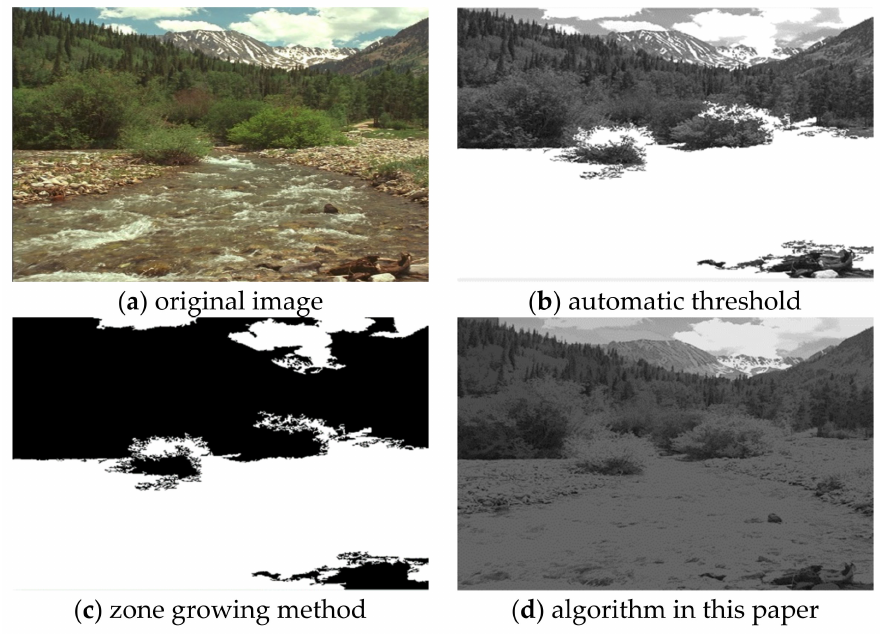
Figure 7. Comparison of Scenery image segmentation results. For the comparison of the three algorithms on Scenery images, the experimental results are shown in Figure